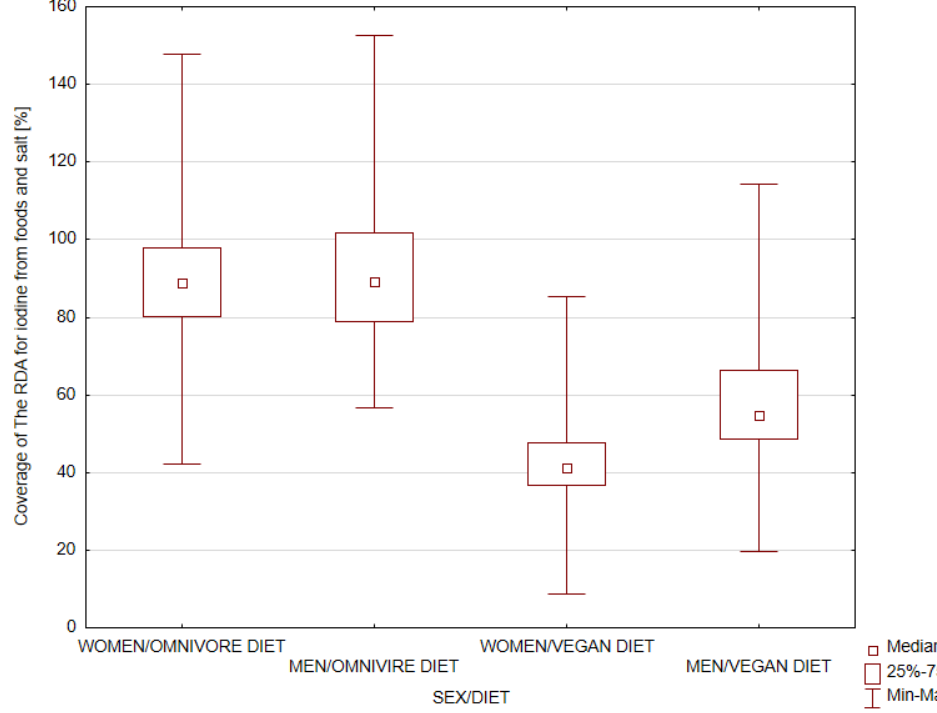
Figure 1. Contribution percentage of food sources to the coverage of total RDA for iodine among women and men in different diet groups (vegan, omnivore) aged 18–80 from Poland. Table 2. Statistical significance of predictors of covariance models for changes in the average weekly coverage of demand for iodine.